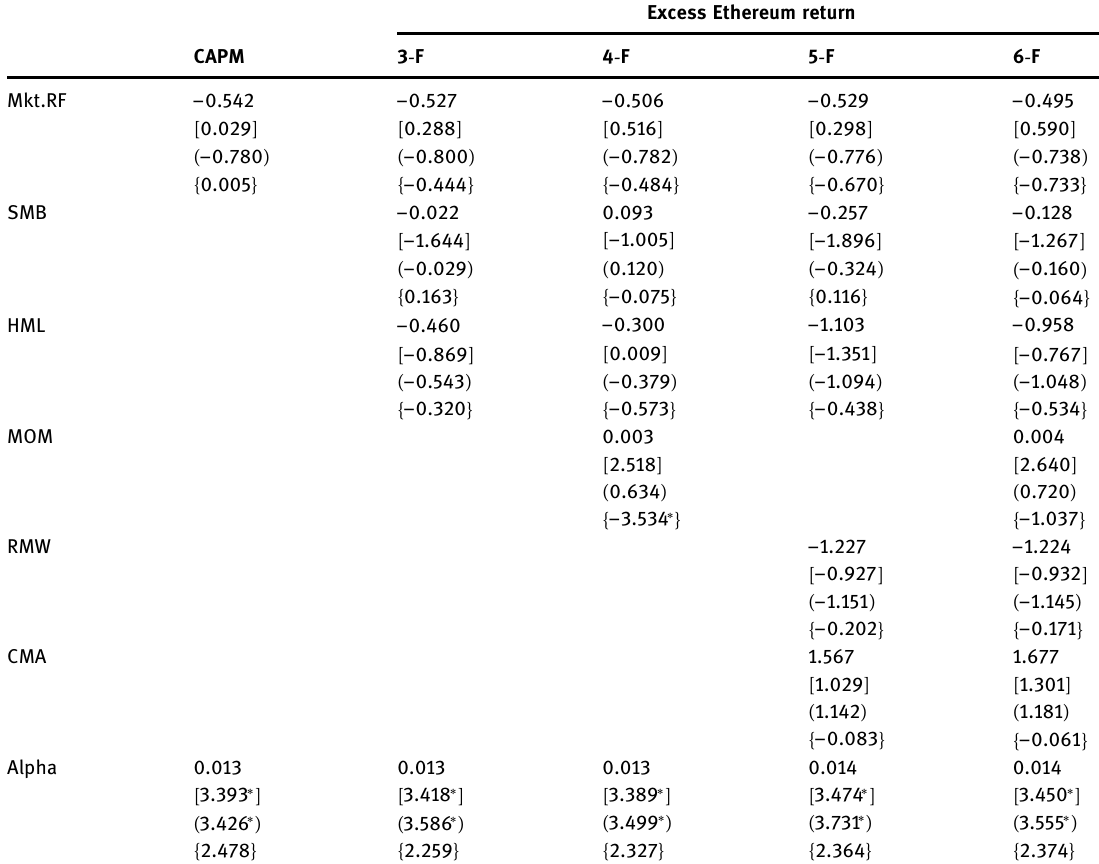
Table A2: Ethereum and stock